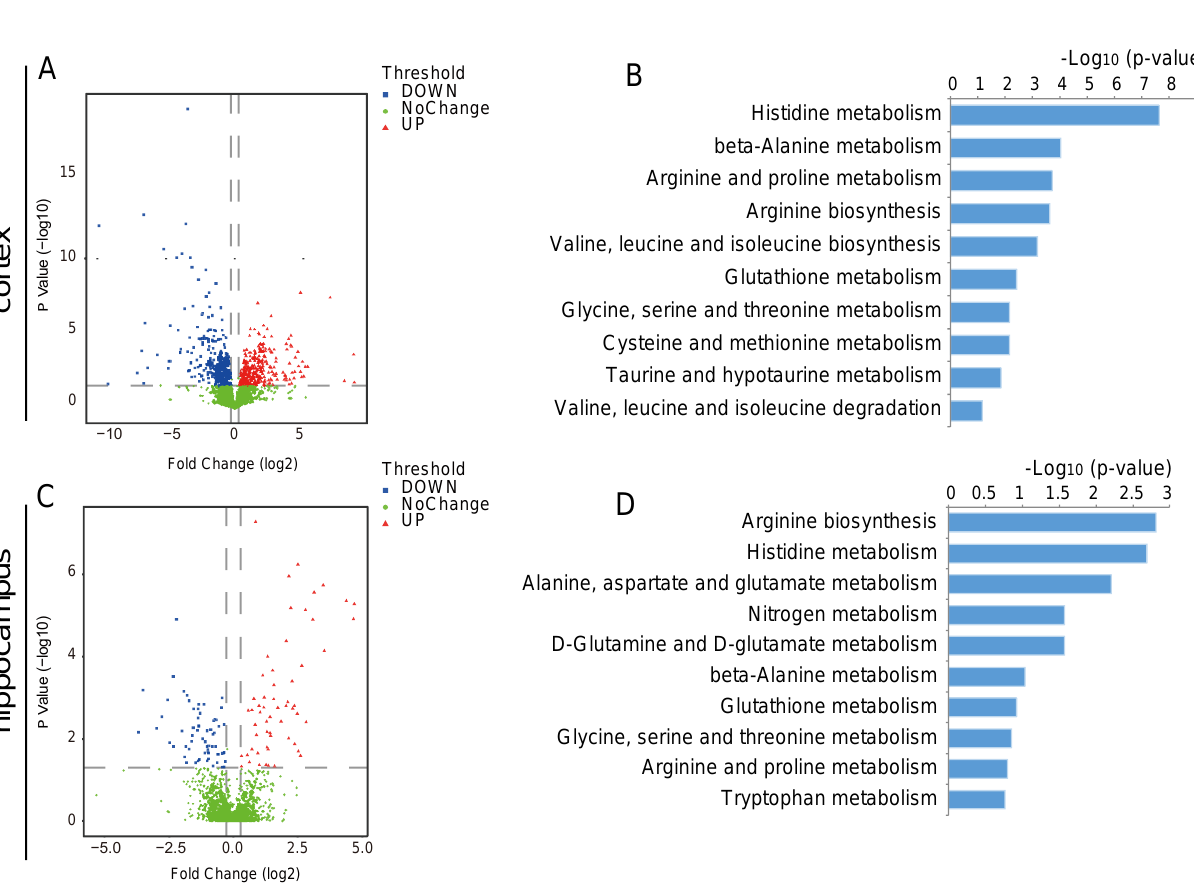
Figure 4. Metabolic characteristics in the acute ischemic cortex and hippocampus. ( A , C ) Volcano plots showing protein differences between control and model groups in cortex ( A ) and hippocampus ( C ). ( B , D ) KEGG metabolic pathway enrichment results of cortex ( B ) and hippocampus ( D ). Next, metabolomics was performed on ischemic cortex and hippocampus samples in order to examine the metabolic impact of scutellarin on acute ischemic injury. Further, PCA and OPLS-DA results illustrated aberrant metabolic expression trends that were effectively redressed by scutellarin in both the cortex (Figure 5A–C) and hippocampus (Figure 5D–F). In total, 226 molecules from 2347 ions were found to contribute to good separations between the hippocampus groups (FC > 1.2 or <0.83, p < 0.05). In total, 127 molecules from 2396 ions were found to contribute to good separations between the cortical groups (FC > 1.2 or <0.83, p < 0.05). The KEGG enrichment results suggested that scutellarin’s metabolic regulation of acute ischemic damage primarily involves a set of amino acid metabolisms in the cortex and hippocampus (Figure 5. G,H). The results indicated that scutellarin rapidly regulates amino acid neurotransmissions in the ischemic region of the brain, which is consistent with proteomics results.